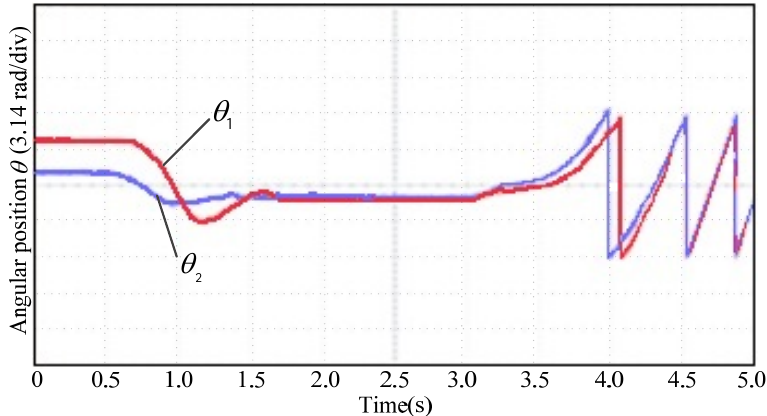
Figure 7. Rotor position alignment during the motor start-up.